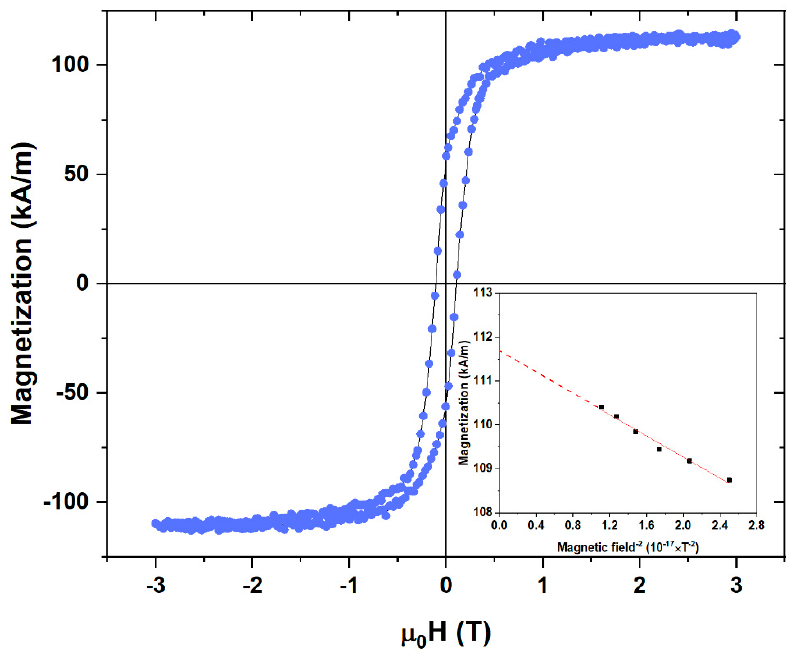
Figure 6. Hysteresis loop of the annealed NPs at 5 K.